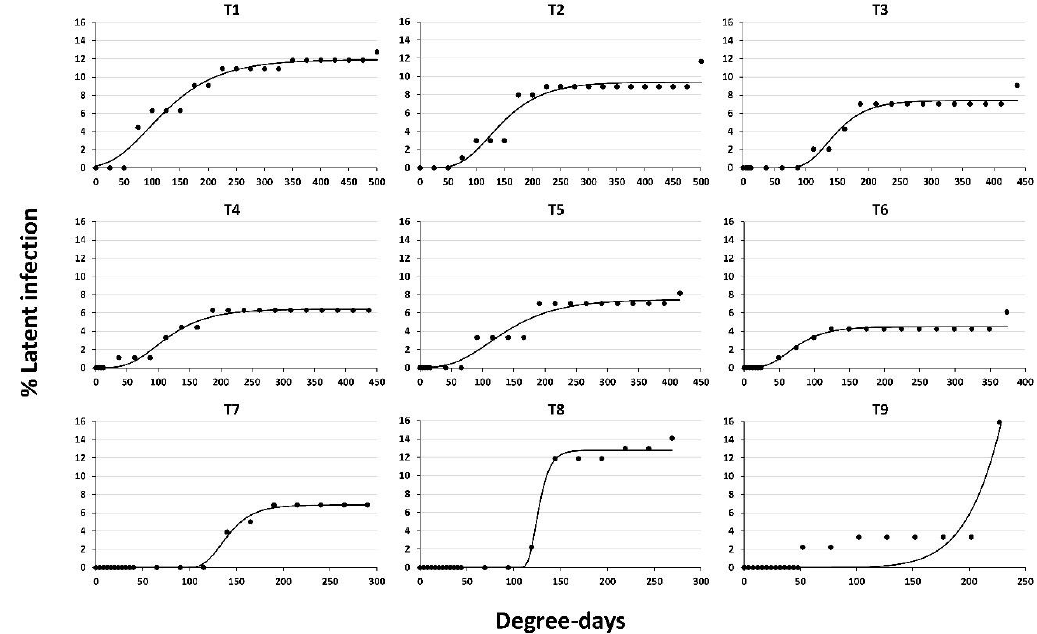
Figure 3. Latent infection incidence of Monilinia spp. on both nectarines fitted to the Gompertz model for physiological time description (DD) under different postharvest conditions: (T1) at 20 °C for 20